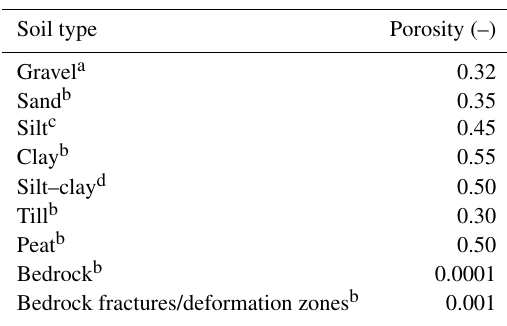
Table 4. Porosity values for different soil types used in the Mike SHE